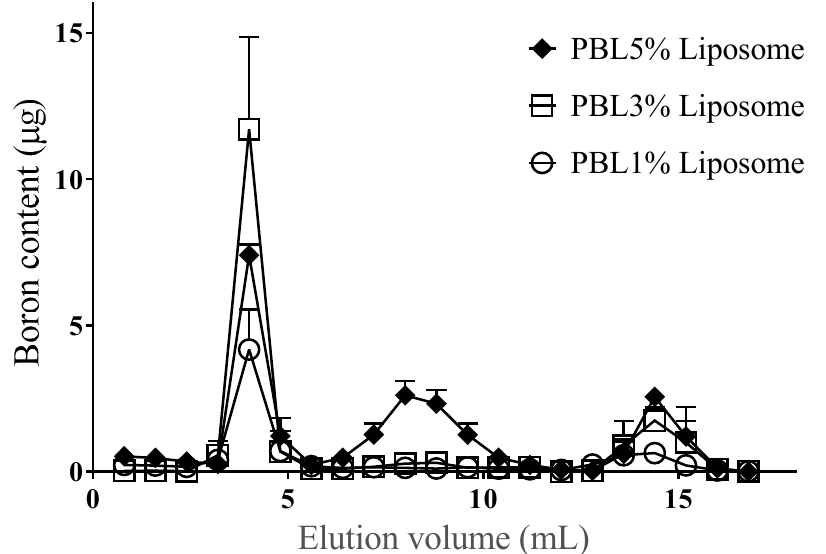
Figure 4. Relationship between the incorporation content of PBL in the liposome with the construction ratio of PBL to liposomes as visualized by size-exclusion chromatography. Each peak represents the following fractions: the first (3.2–4.8 mL) is the liposome peak, the second (4.8–10.4 mL) is the micelle peak, and the third (13.6–15.2 mL) is the monomolecular peak. Data are expressed as means ± S.D. ( n = 3).